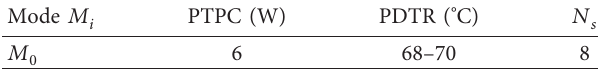
Table 3: An example of Constraint Set for Explorer. Mode M